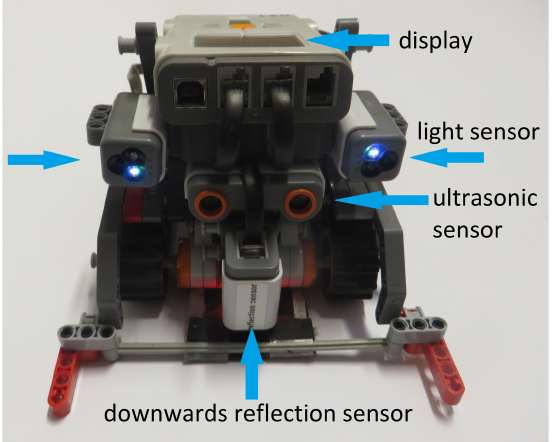
Fig. 1 . Detailed front view of the robot with its four sensors. The motors and belts for moving the robot are positioned on the sides and are not